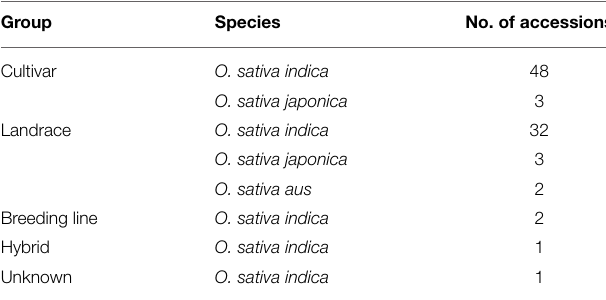
TABLE 1 | Different groups and rice accessions used in mining for blast resistance gene